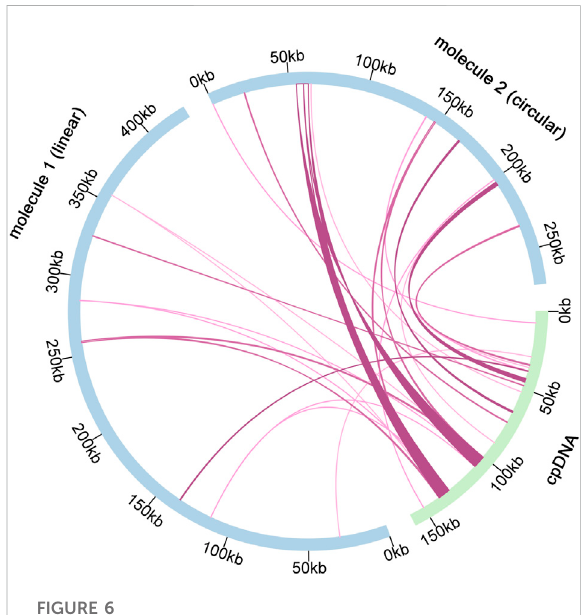
FIGURE 6 Schematic representation of gene transfers between chloroplast and mitogenome in C. acerifolia . The blue arcs in the diagram represent the mitogenome, the green arcs represent the chloroplast genome, and the rosy red lines between the arcs correspond to the genomic fragments that are